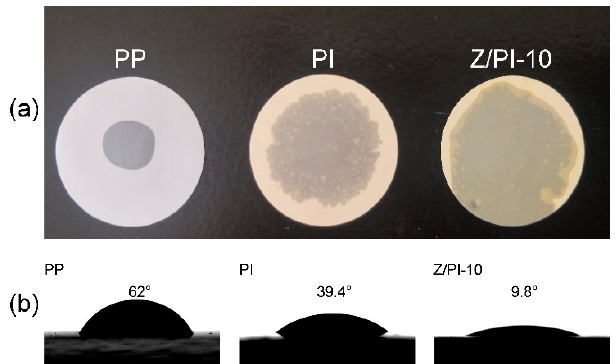
Figure 6. ( a ) Photograph showing the wetting behavior of the separators wetted by liquid electrolyte. ( b ) Contact angle test of PP, PI, and Z/PI-10 separators with liquid electrolyte.